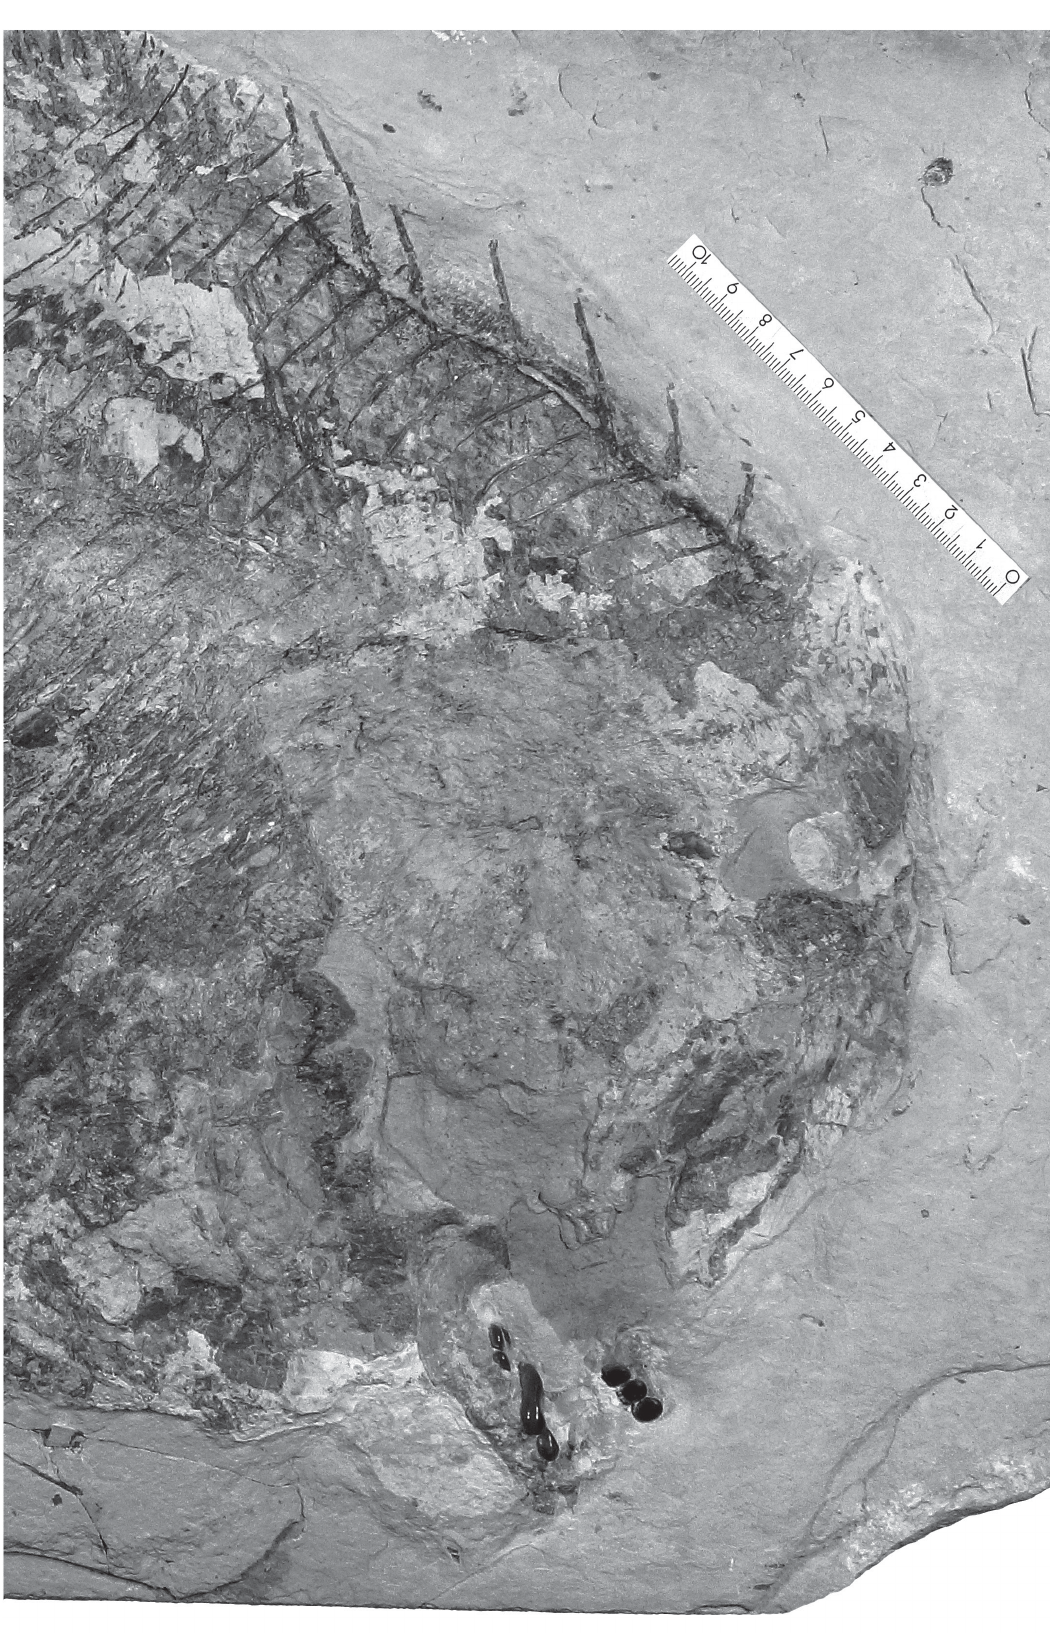
Fig. 16. Sigmapycnodus giganteus gen. et sp. nov., holotype, head region (CLC S-497b.)